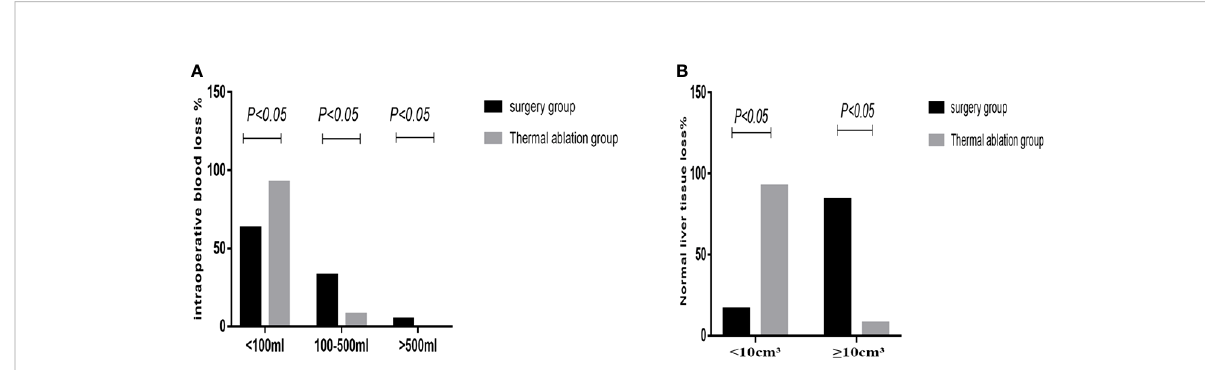
FIGURE 3 Statistical chart of intraoperative bleeding and loss of normal liver tissue in the two groups. (A) Statistical chart of intraoperative bleeding. (B) Loss of normal liver tissue statistical chart.